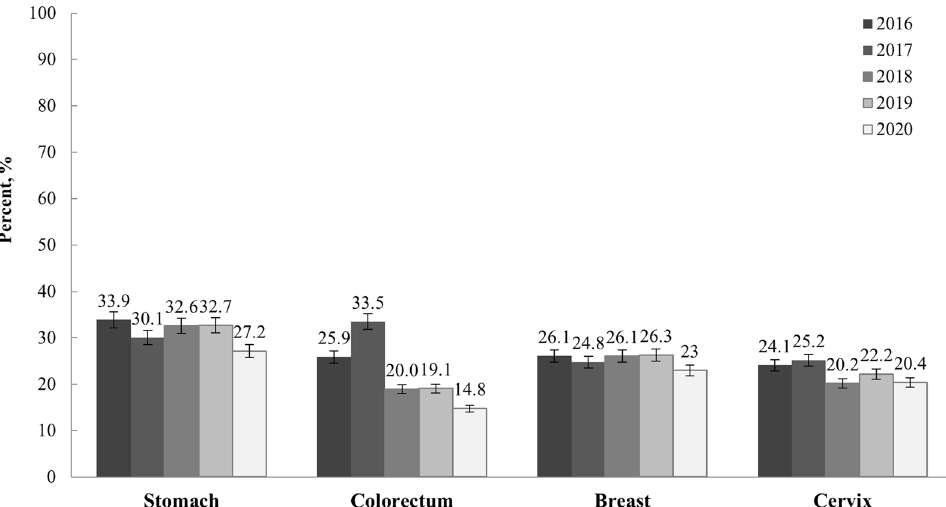
Figure 1. Latest cancer screening rates within the last 1 year for the period 2016–2020. The cancer screening rates were measured according to cancer screening protocols issued by the NCSP of Korea: Stomach, Percentage of adults aged ≥ 40 years who underwent stomach cancer screening using either UGIS or endoscopy. Colorectum, Percentage of adults aged ≥ 50 years who underwent colorectal cancer screening using FIT. Breast, Percentage of women aged ≥ 40 years who underwent breast cancer screening using mammography. Cervix, Percentage of women aged ≥ 20 years who underwent cervical cancer screening using conventional